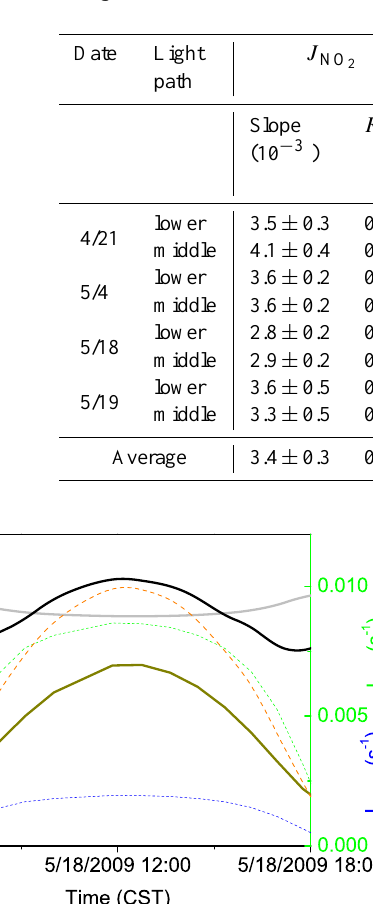
Table 1. Linear fit results of Fig. 8.